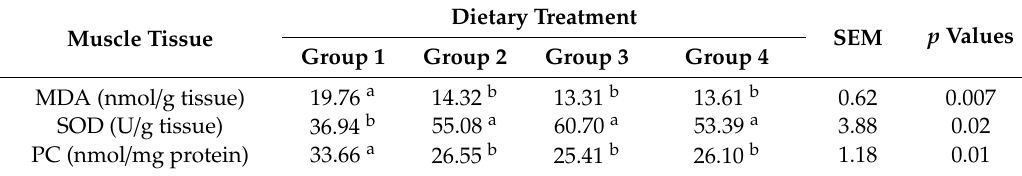
Table 7. Antioxidant status in breast muscle of broilers chickens fed di ff erent species of microalgae for 32